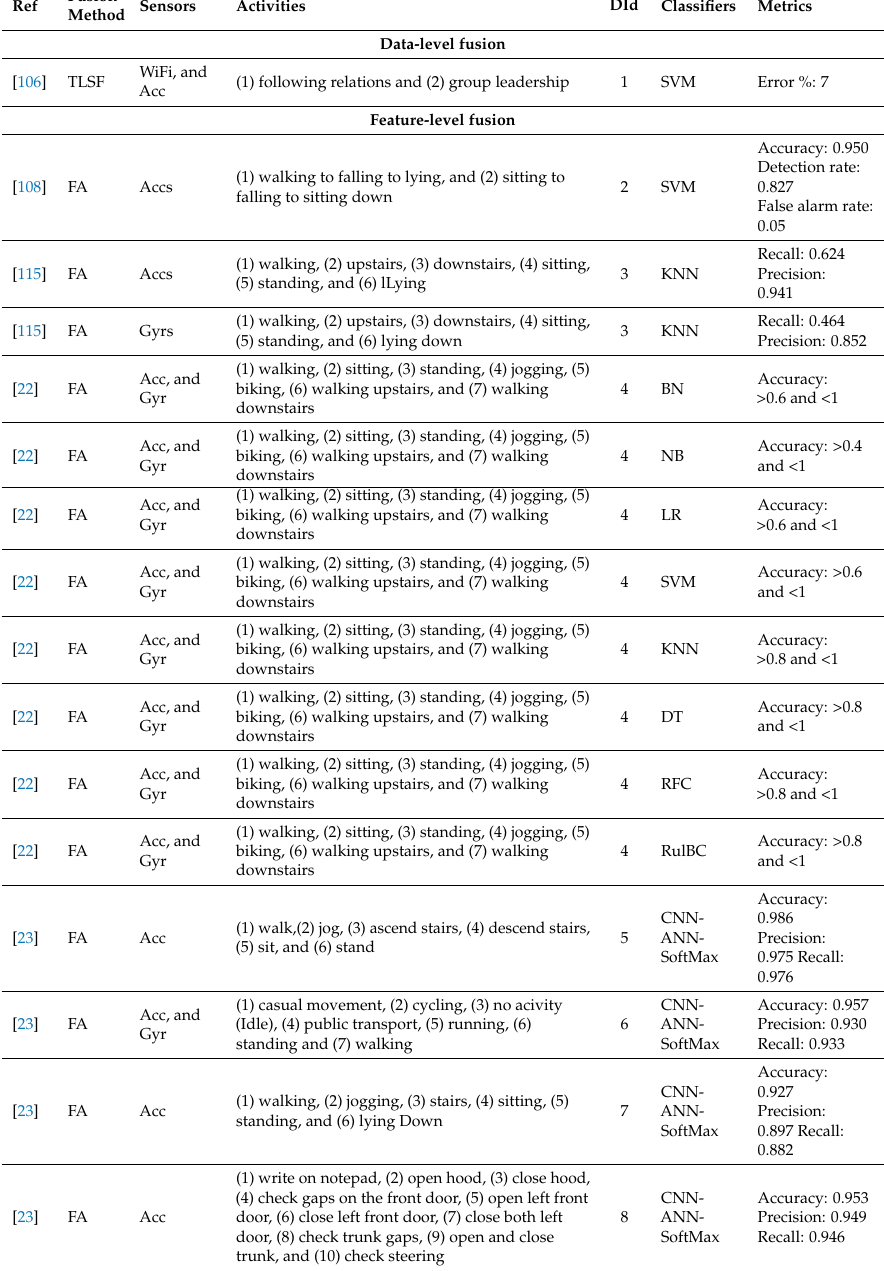
Table 9. Summary of articles that propose methods that combine data at the level of data or at the level of features. Ref = Reference and DId = Dataset ID. Acc(s) = Acceleromter(s), Mag(s) = Magnetometer(s), Gyr(s) = Gyroscope(s), Kc = Kinect camera, Hr = Heart rate, Av = Anthropometric variables, Res = Respiration, Press = Pressure Mic(s)= Microphone(s), Vid(s) = Videos(s), IMU = Inertial measurement unit, Mot = Motion, and Ven =